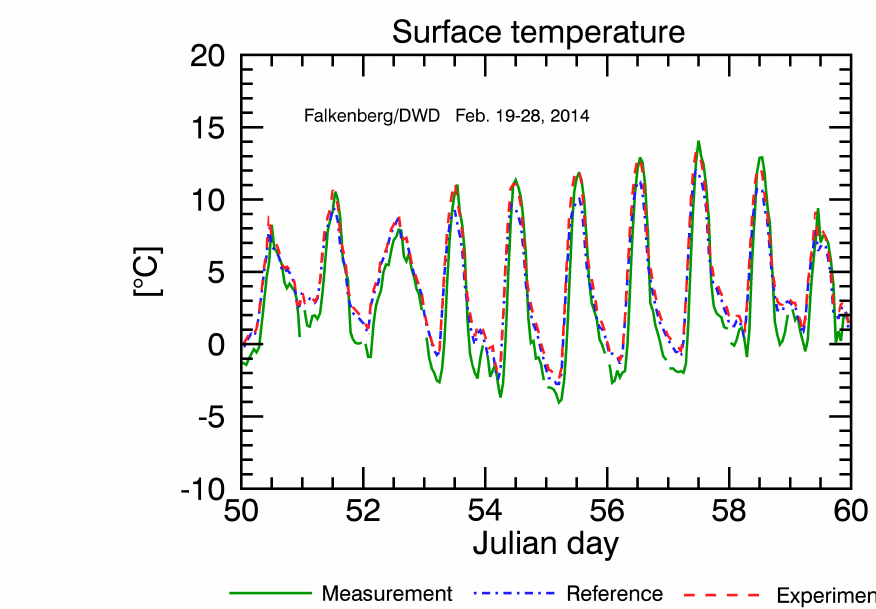
Figure 4. Diurnal cycles of the surface temperature as measured at Falkenberg on 19–28 February 2014 (Julian day 50–59) compared to the results of the reference version of TERRA based on BATS and of the new scheme based on a resistance formulation (experiment).